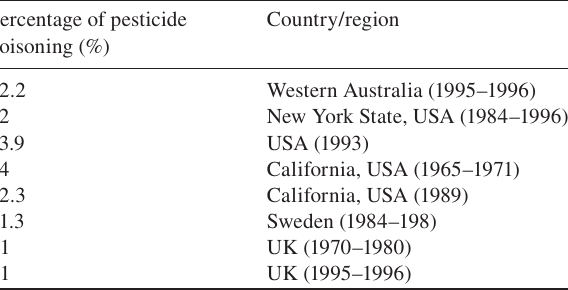
Table 2 Pesticide poisoning incidence from overall injuries in